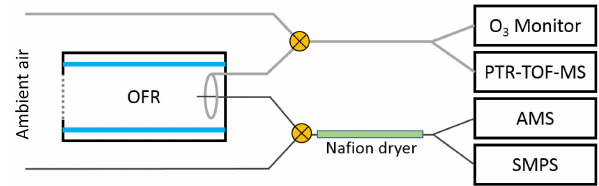
Figure 1. Simplified schematic of the experimental setup. Ambi- ent air was alternately sampled either directly or through the oxida- tion flow reactor (OFR). In the OFR, the concentration of OH was increased to simulate atmospheric aging from hours up to several